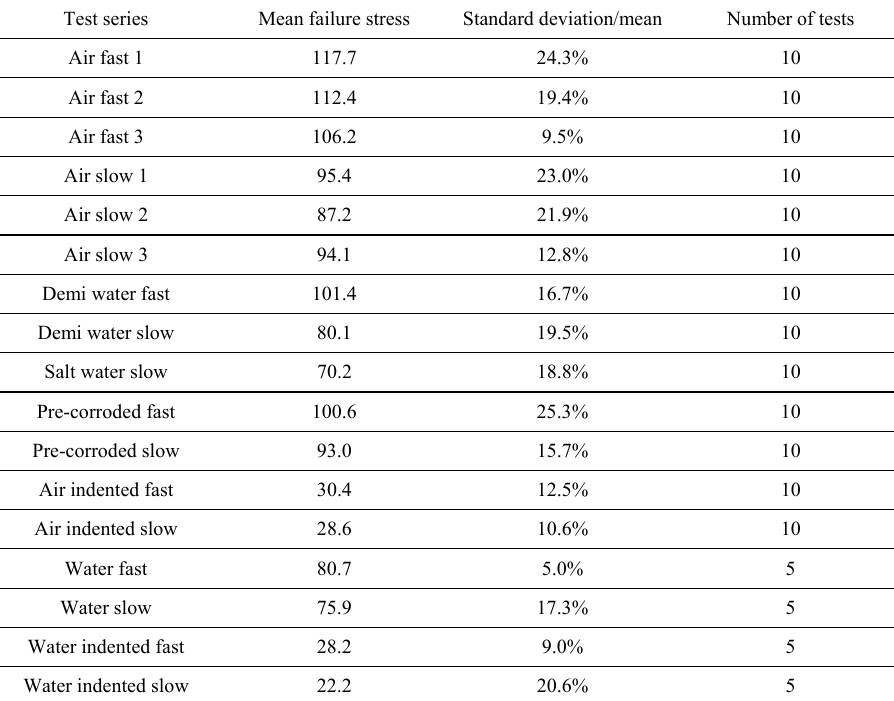
Table 5: summary of